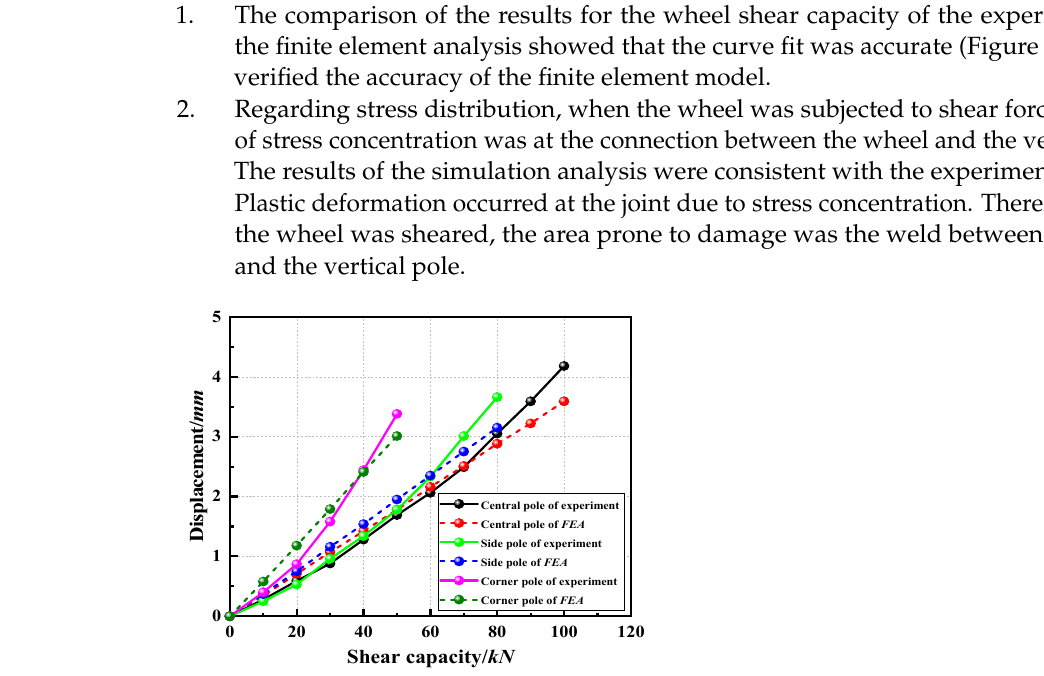
Figure 15. Finite element analysis of the wheel shear capacity.